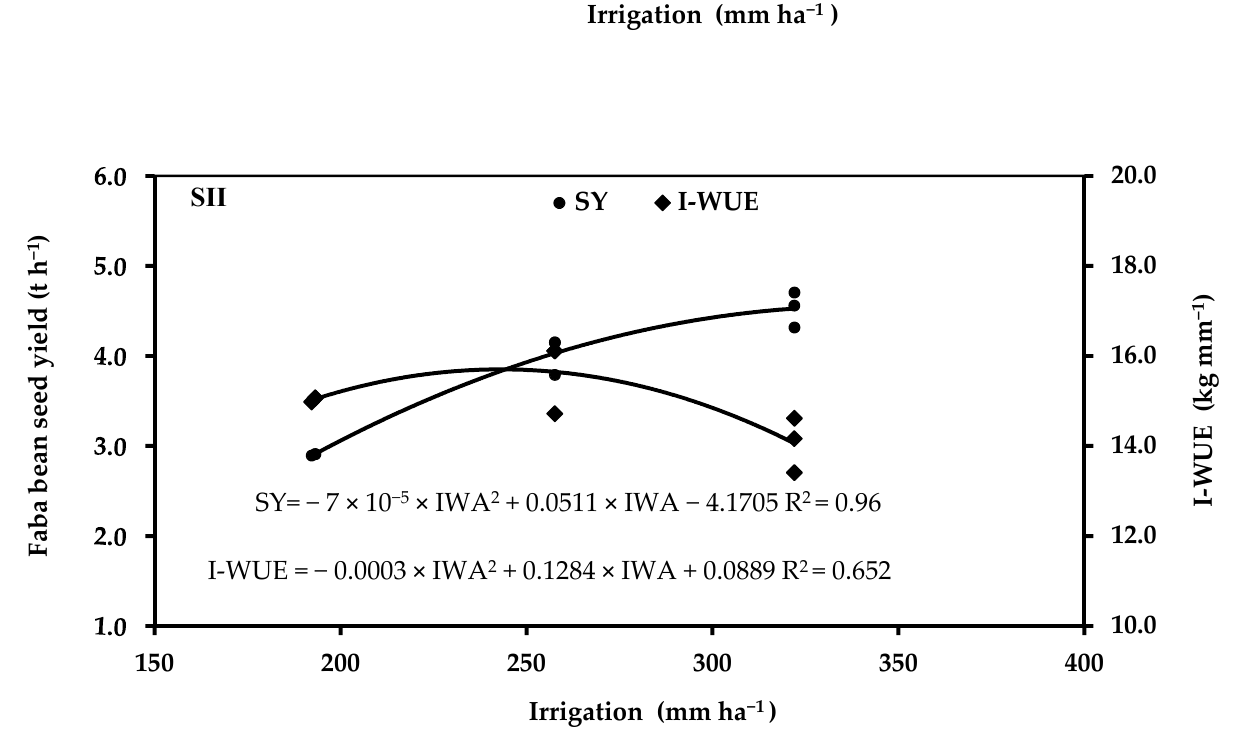
Figure 3. Regression analysis between irrigation water applied (IWA), faba bean seed yield (SY), and irrigation-water use efficiency (I-WUE) in S I (2016/17) and S II (2017/18) seasons.